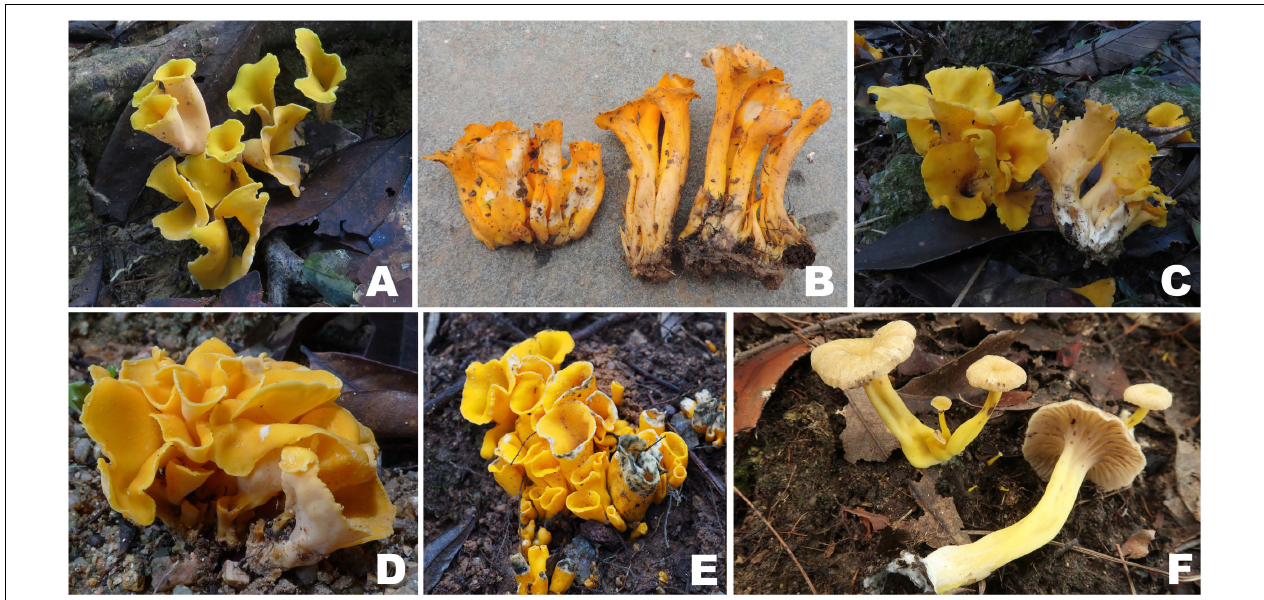
FIGURE 3 | Basidiomata of Craterellus species. (A–E) C. aureus (A) FHMU2100; (B) FHMU6549; (C) FHMU2102; (D) FHMU2407; (E) FHMU6550; (F) C. fulviceps (FHMU6553, holotype). Photos: (A,C,D) N.-K. Zeng; (B,E) M.-S. Su; (F) P.